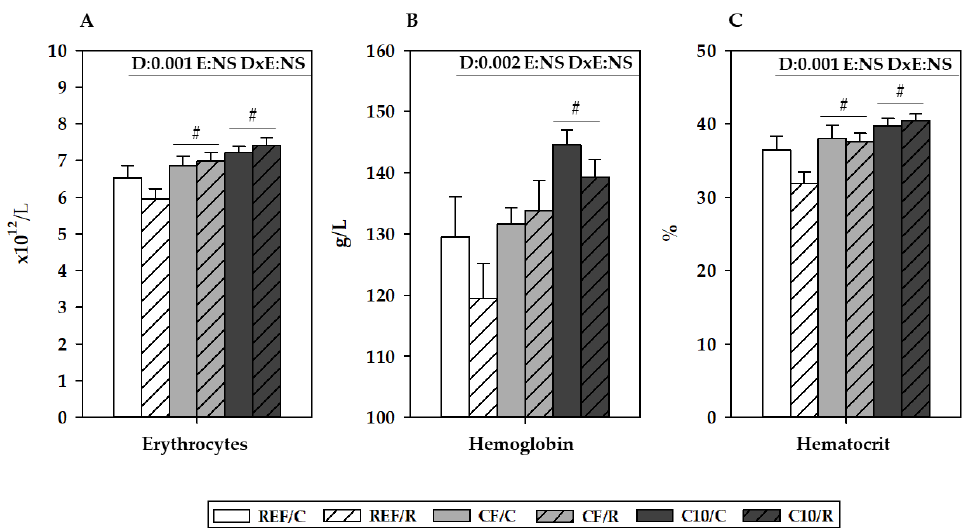
Figure 4. Blood erythrocyte counts ( A ), hemoglobin concentration ( B ), and hematocrit ( C ) 16 h after performing the final exhaustion test. REF, reference diet; CF, 5% cocoa fiber-enriched diet; C10, 10% cocoa-enriched diet. The control (C) groups are represented by smooth bars, and the runner (R) groups are represented by striped bars. Data are expressed as mean ± SEM (n = 8). Statistical differences (two-way ANOVA followed by Tukey ’s post-hoc test): # p <0.05 vs. the REF diet.